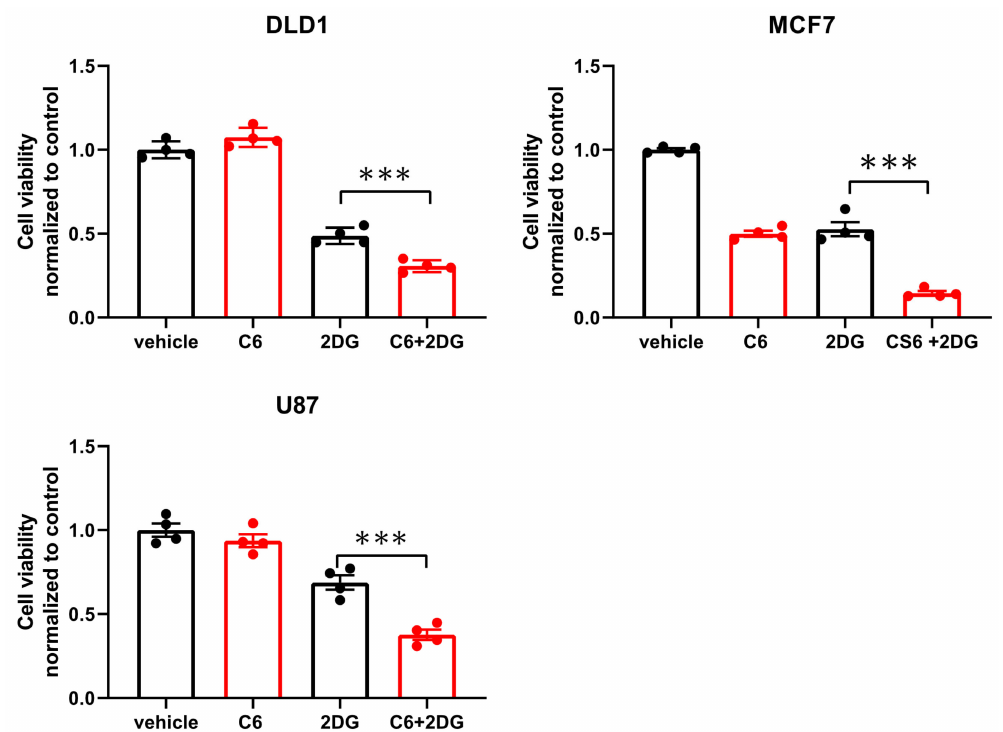
Figure 4. Compound 6 is toxic under glycolysis inhibition. Relative cell viability of the indicated cell lines treated for 24 h with: vehicle (the same volume of DMSO as in the highest concentration of compound 6 with glucose) and 5 µ M of compound 6 (C6), 2DG (25 mM), alone or in combination. Cell viability was measured using Crystal Violet staining. Results are normalized to control (vehicle). *** p <